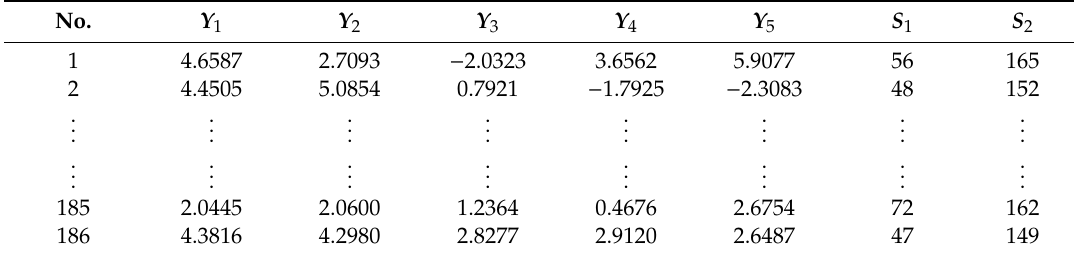
Table 7. Perturbed data using the GADP method.